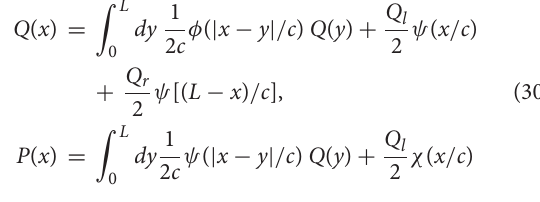
x 2 t β with β h i ∼